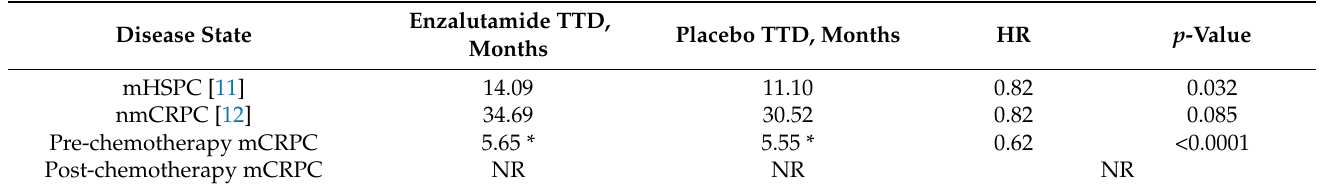
Table 5. Time to deterioration for BPI-SF worst